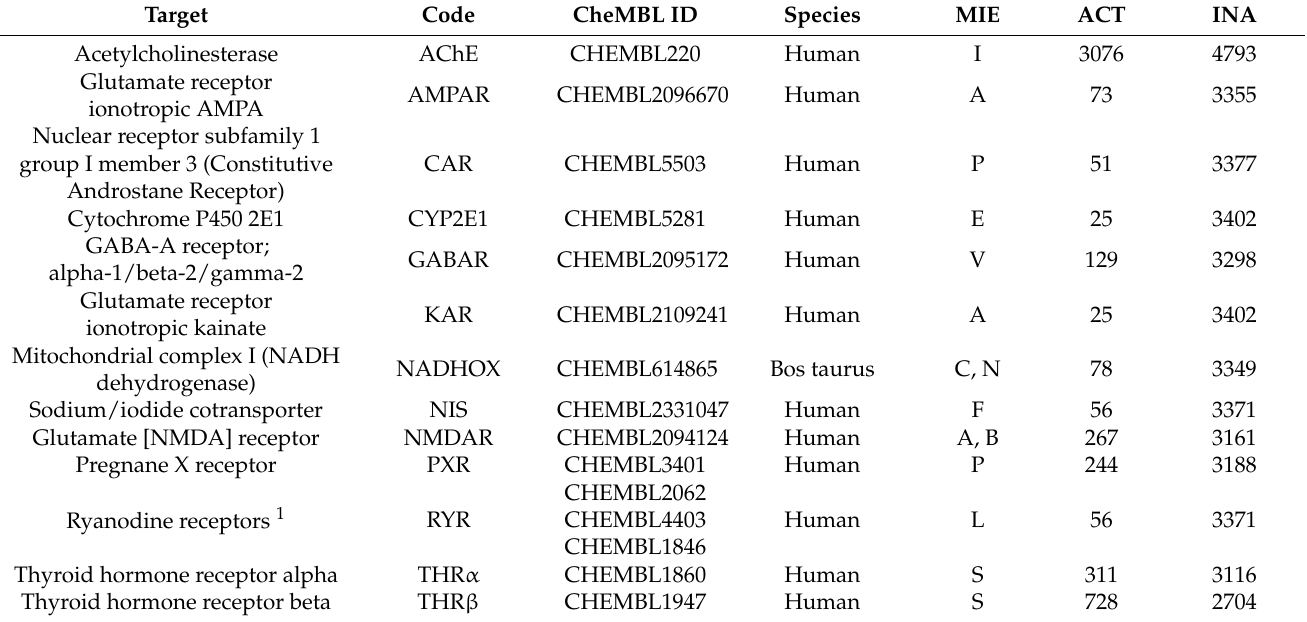
Table 4. List of endpoints modelled using ChEMBL data. For each endpoint, the reference MIE, ChEMBL ID relative to the molecular target, species, and composition of the Training and Test sets are reported; ACT is the number of active compounds, while INA is the number of inactive